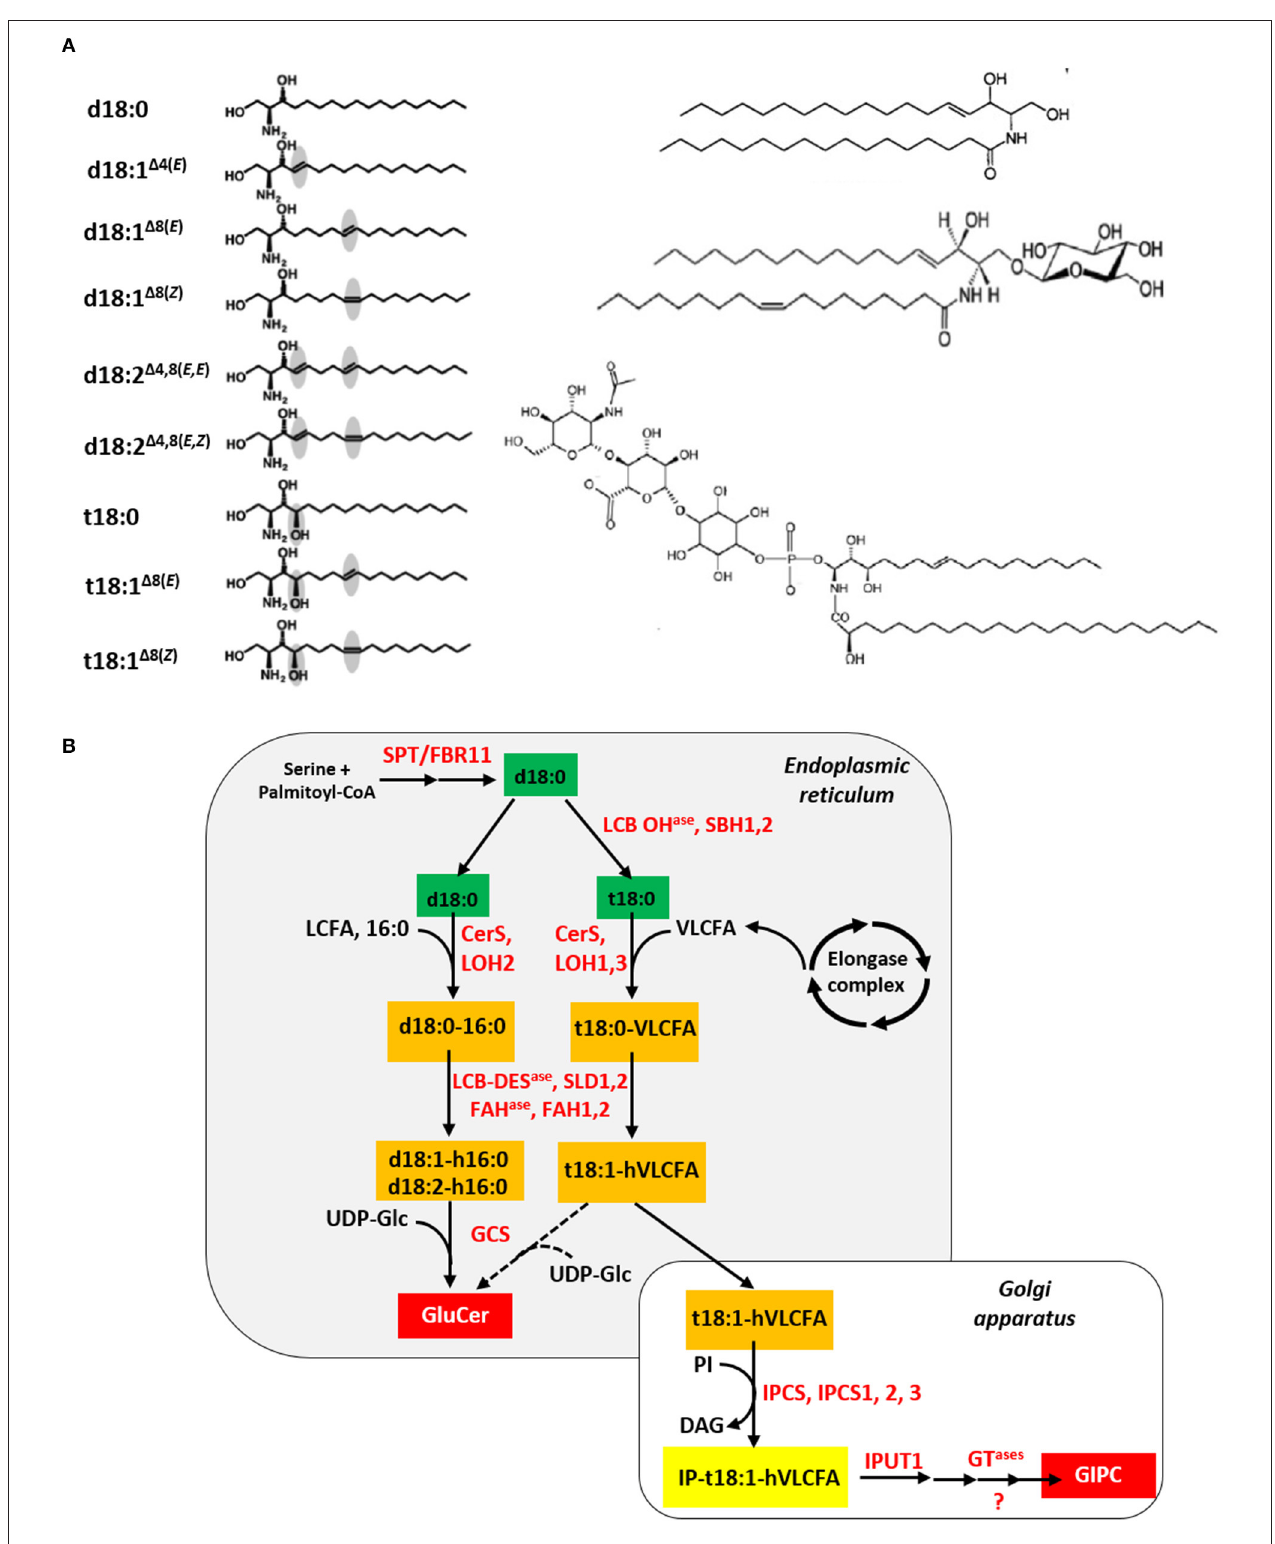
FIGURE 2 | Plant sphingolipid synthesis. (A) The four classes of plant sphingolipids (from Cacas et al., 2012a). The left panel displays the nine molecular species of long-chain bases found in plants, from top to bottom: sphinganine/dihydrosphingosine, d18:0; sphingosine/sphing-4( trans )-enine, d18:1 1 4( E ) ; sphing-8( trans )-enine, d18:1 1 8( E ) ; sphing-8( cis )-enine, d18:1 1 8( Z ) ; sphinga-4,8( trans , trans )-dienine, d18:1 1 4 , 8( E,E ) ; sphinga-4,8( trans , cis )-dienine, d18:1 1 4 , 8( E,Z ) ;